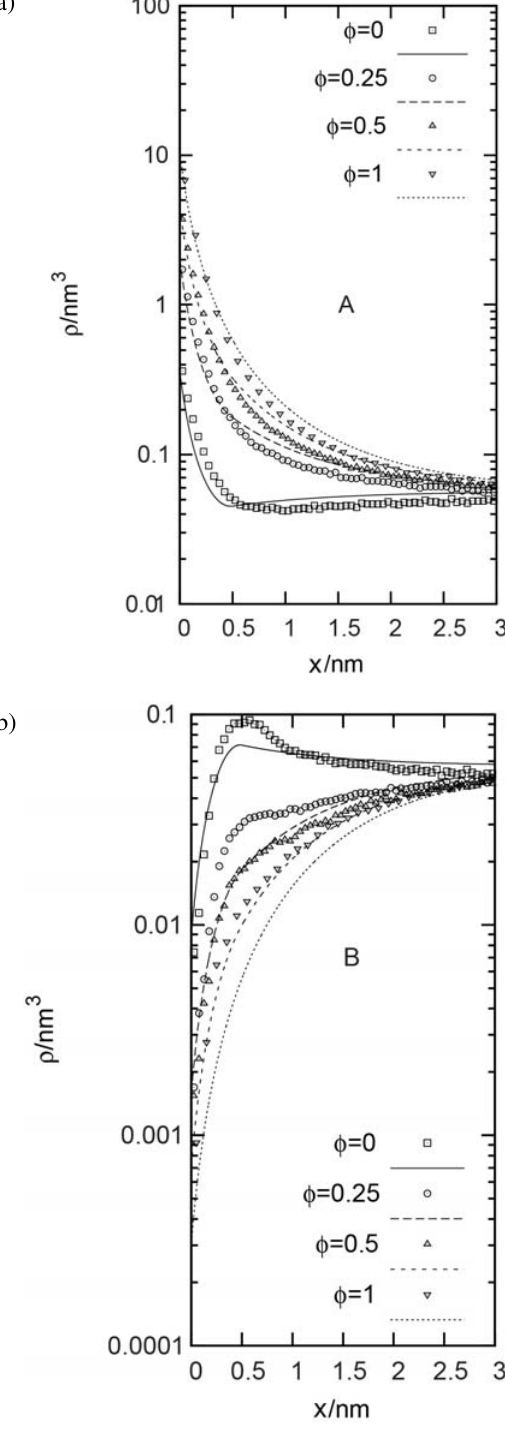
Figure 5. Density profiles of small mobile ions next to the zwitte- rionic layer at Debye length equal to 1 nm and at a = 0.65 nm 2 for three values of φ . Symbols represent Monte Carlo data and lines theory. Legend: (cid:3) and full line: φ = 0; (cid:2) and - - -: φ =0.25; (cid:2) and - - -: φ = 0.5; (cid:3) and …: φ = 1. Note the value of φ = 0 means that all zwitterions are electroneutral, whereas the value 0 means that Figure 4. Density profiles of small mobile ions next to the zwitte- there are no zwitterions at all, only negative phosphate groups re- rionic layer at Debye length equal to 0.5 nm. Notation is the same main on the plate. Panel A displays cations’ density profiles while as for Figure 2, except for the corresponding monovalent salt con- the panel B density of anions next to the zwitterionic layer. centration, which is 0.37 mol/L. Re{~i~ and Bohinc: Electrolyte Solution at Zwitterionic Lipid Layer ...